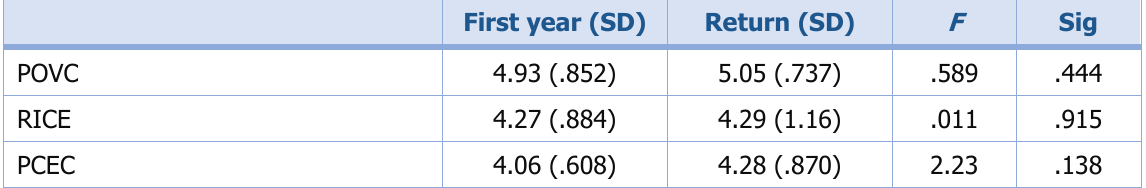
Table 4: Post-Camp Differences Between First-Year (n = 44) and Returning Counselors’ (n = 69) Creativity